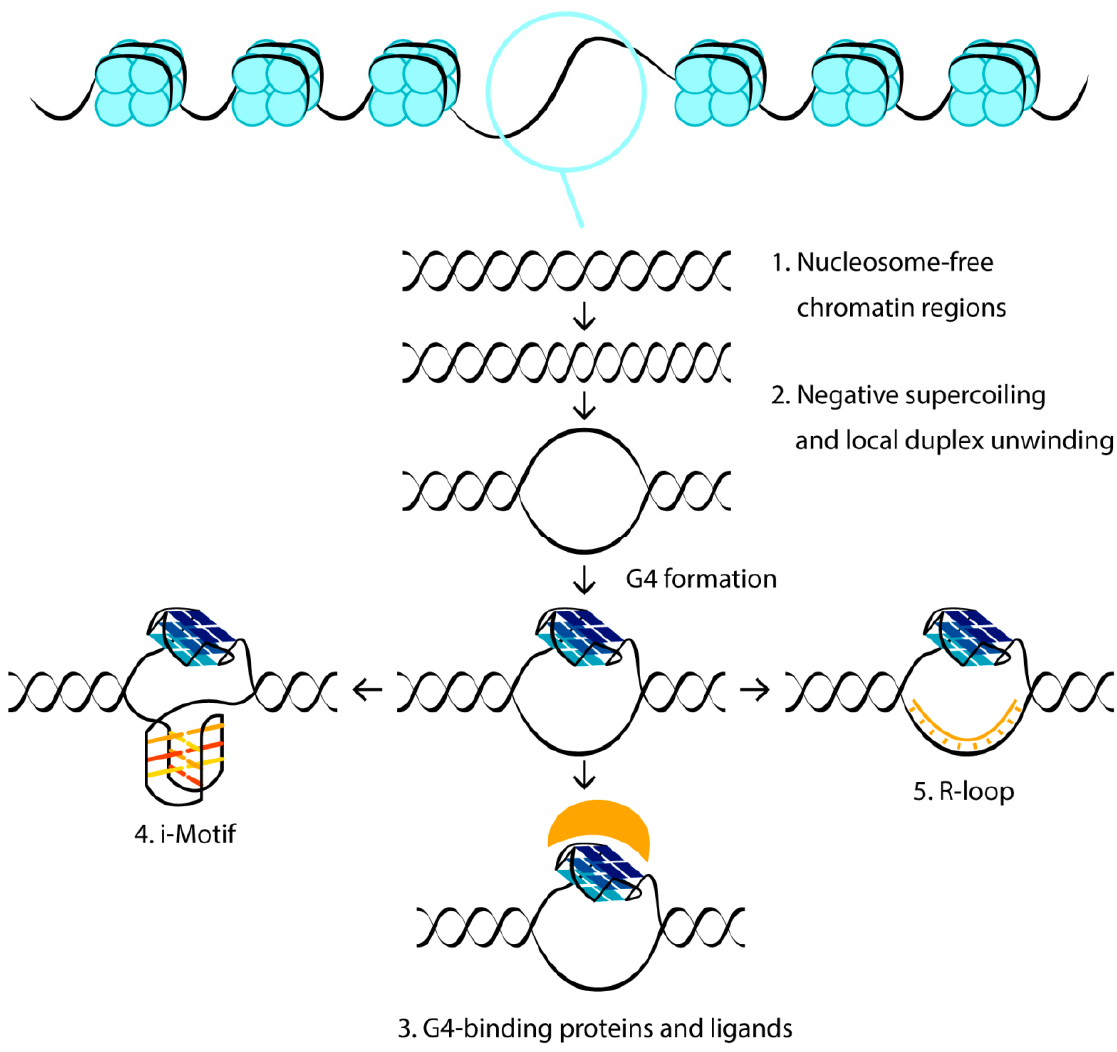
Figure 1. Cellular factors contributing to the folding and stabilization of G4 structures. Blue circles represent histones, G4-binding proteins and low molecular weight ligands are shown in yellow.